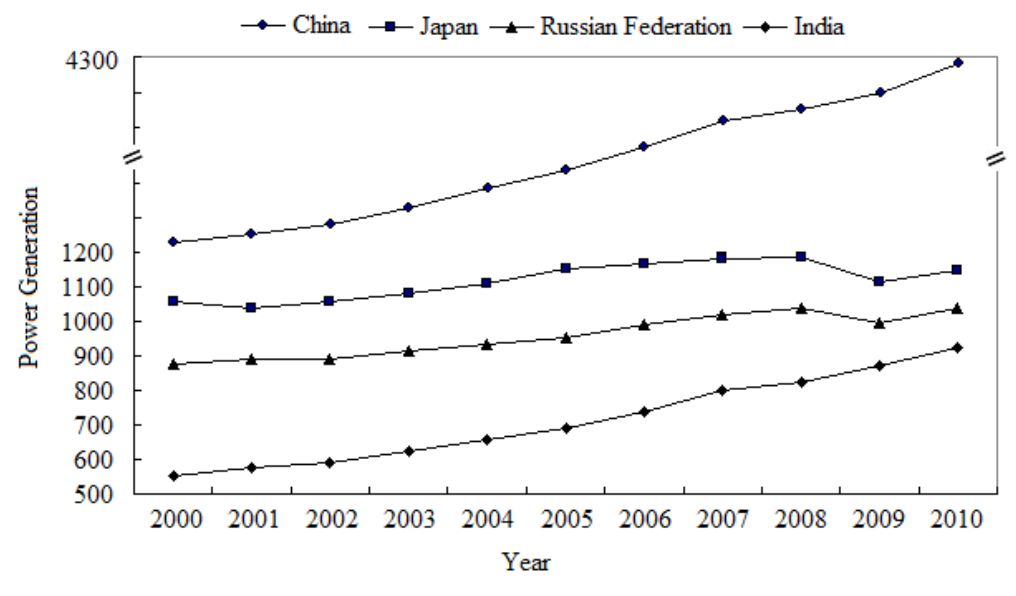
Figure 1. Yearly power generation in China, Japan, Russian Federation and Indian from 2000 to 2010